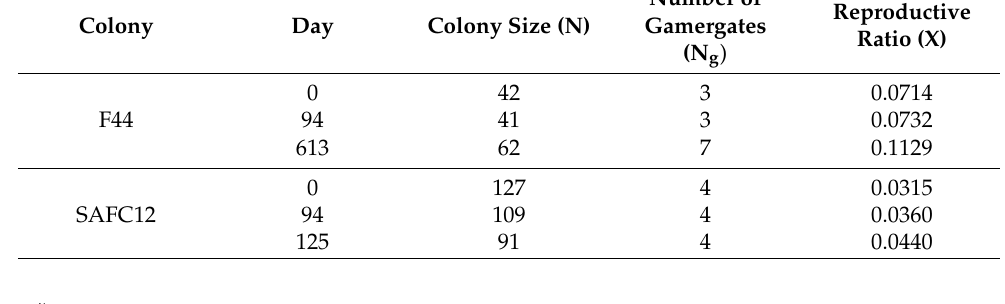
Table 2. Time series data for colonies F44 and SAFC12.